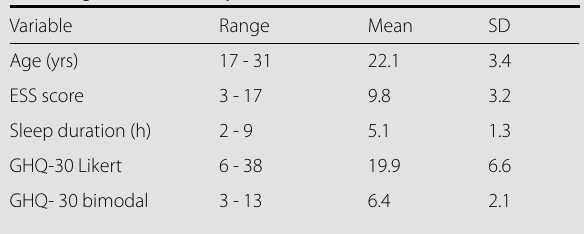
Table I. Age, ESS score, sleep duration and